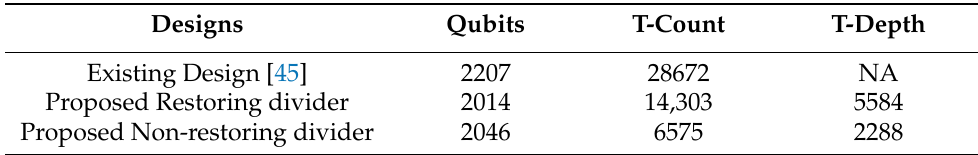
Table 5. Comparison of proposed single precision slow floating-point division quantum circuits with the existing